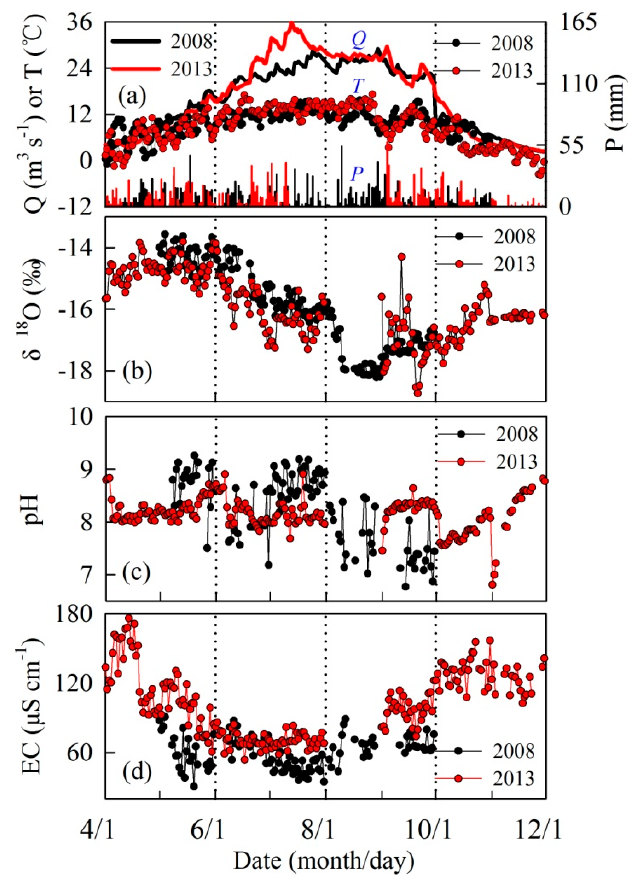
Figure 2. Seasonal variations in river discharge (Q), air temperature (T) and precipitation (P) ( a ), as well as δ 18 O ( b ), pH ( c ) and electrical conductivity (EC); ( d ) in river water at the Hailuogou basin over